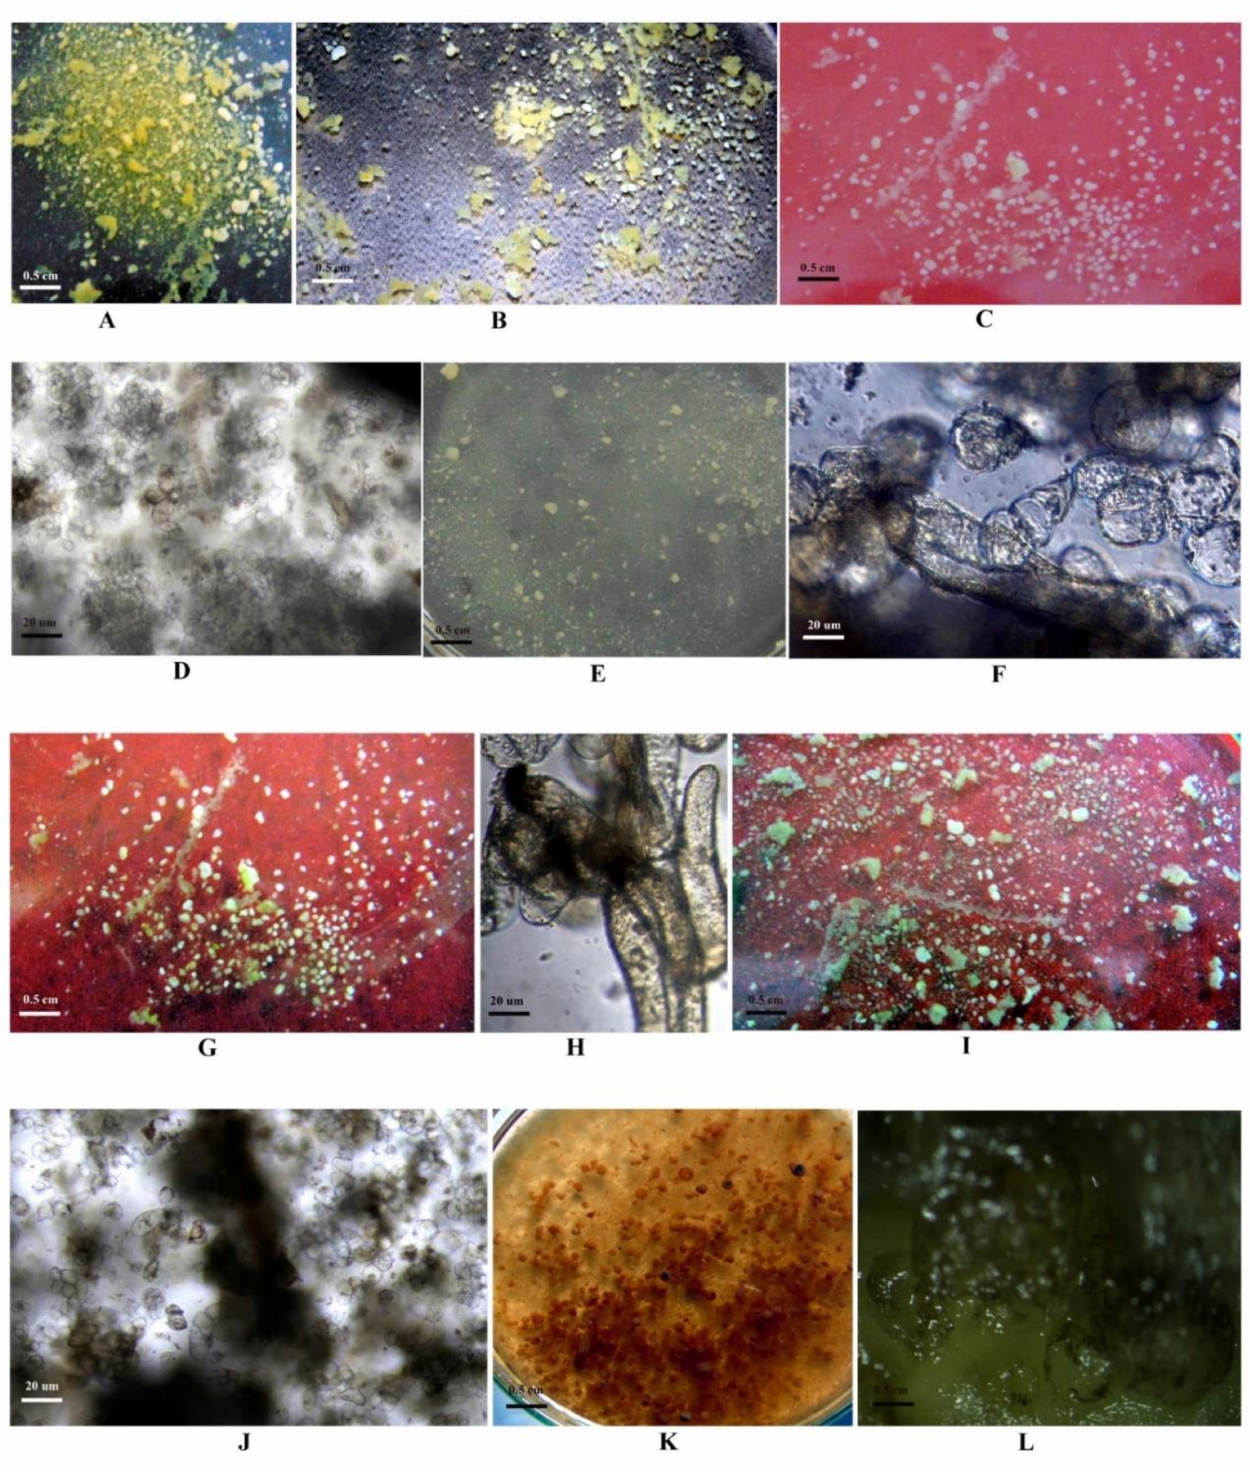
Figure 3. Effect of different concentrations of PEG6000 on survival of clumps/embryoids in liquid selection medium in soybean. ( A ) PEG6000 0% ( w/v ); ( B ) PEG6000 5% ( w/v ); ( C , D ) PEG6000 10% ( w/v ); ( E , F ) PEG6000 15% ( w/v ); ( G , H ) PEG6000 20% ( w/v ); ( I , J )